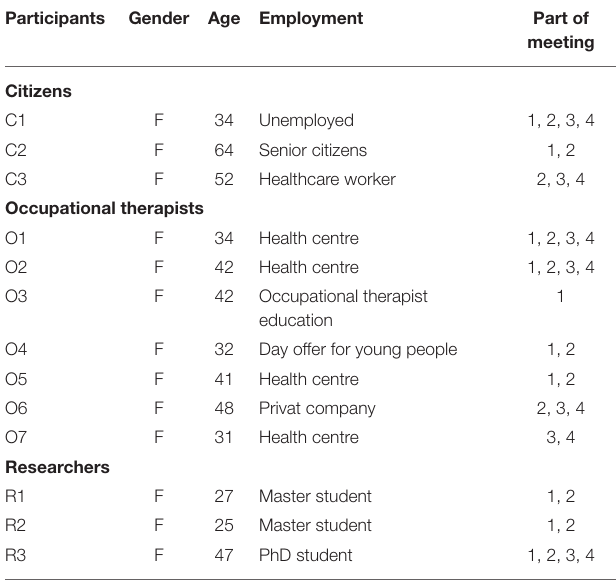
TABLE 3 | Participants included in the